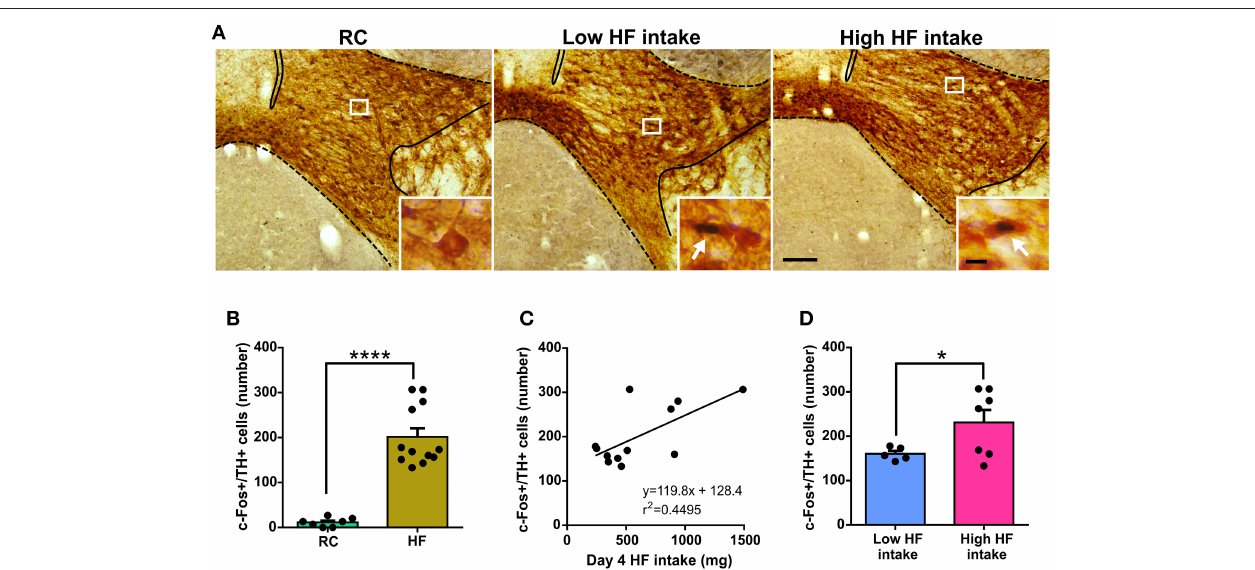
FIGURE 3 | (A) Representative photomicrographs of the double c-Fos/TH immunostaining in the VTA of RC, Low HF intake and High HF intake groups. In each picture, the limits of the VTA are overlaid according to the delineation described in the Mouse Brain Atlas ( 10). Insets show, in high magnification, the areas delimited by rectangles in low magnification images. Arrows point at dual-labeled cells. Scale bars: 100 µ m, low magnification and 10 µ m, high magnification. (B) Quantitative analysis of the number of c-Fos + /TH + cells in the VTA of RC and HF groups. Bars represent the mean ± SEM and dots represent the individual c-Fos + /TH + values for each mouse. **** p < 0.0001, unpaired t -test with Welch’s correction ( t = 9.716, df = 11.83). (C) Scatter plot of c-Fos + /TH + cells number vs. day 4 HF intake. The linear regression between both parameters is shown with the corresponding equation and R squared. The linear regression presented a slope significantly different from zero according to an F test ( p = 0.0170, F = 8.166). (D) Quantitative analysis of the number of c-Fos + /TH + cells in the VTA of low HF intake and high HF intake groups. Bars represent the mean ± SEM and dots represent the individual c-Fos + /TH + values for each mouse. * p < 0.05, unpaired t -test with Welch’s correction ( t = 2.446, df =